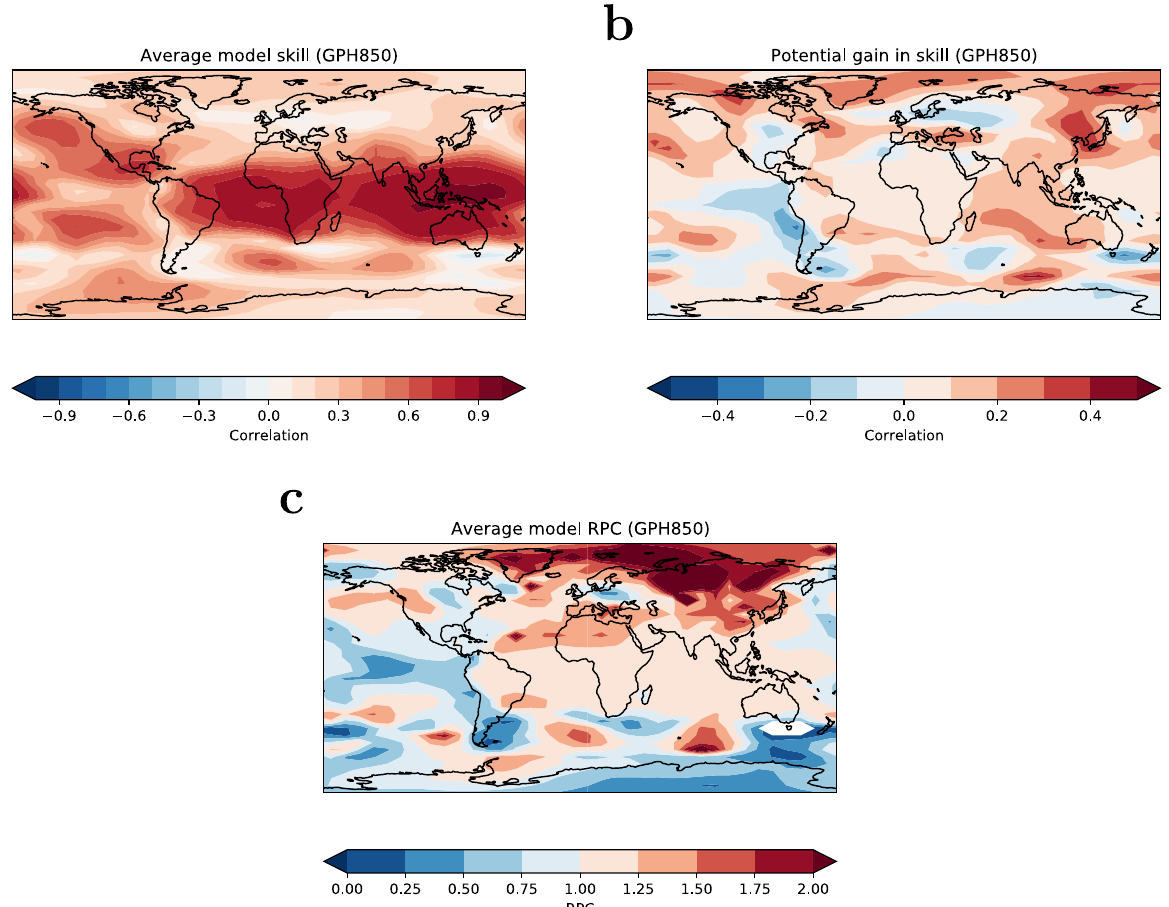
Fig. 4 Model skill. Maps of a Average model skill, b potential gain in skill by improving EFP to observed values (see Methods section for details) and c Ratio of Predictable Components averaged across skilful models (those used in Fig. 1c). In b , red colours denote regions where skill could potentially be improved by a more accurate simulation of the eddy feedback parameter. In c , red colours denote regions where the signal-to-noise paradox is evident, and white indicates regions where model skill is negative for all